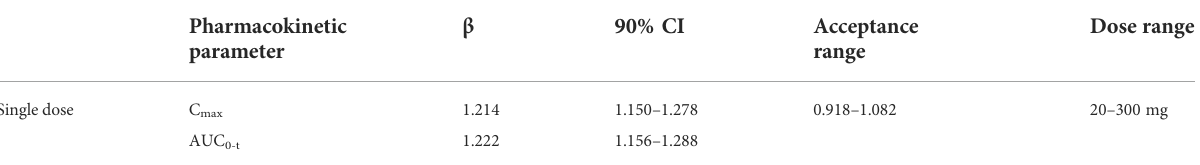
TABLE 4 Assessment of dose proportionality of SAA based on the power model.